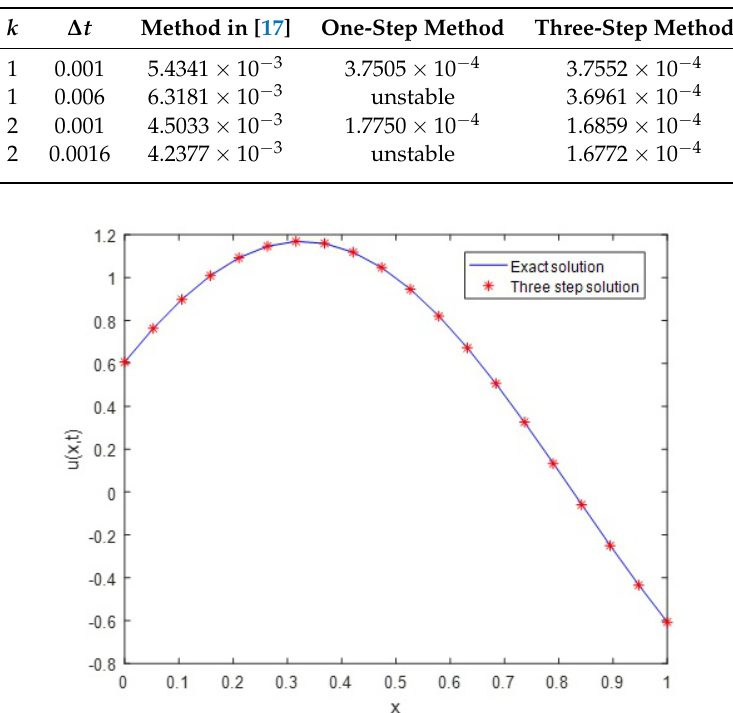
Figure 5. The exact solution of Example 3 in the case M = 8, k = 2 and ∆ t =